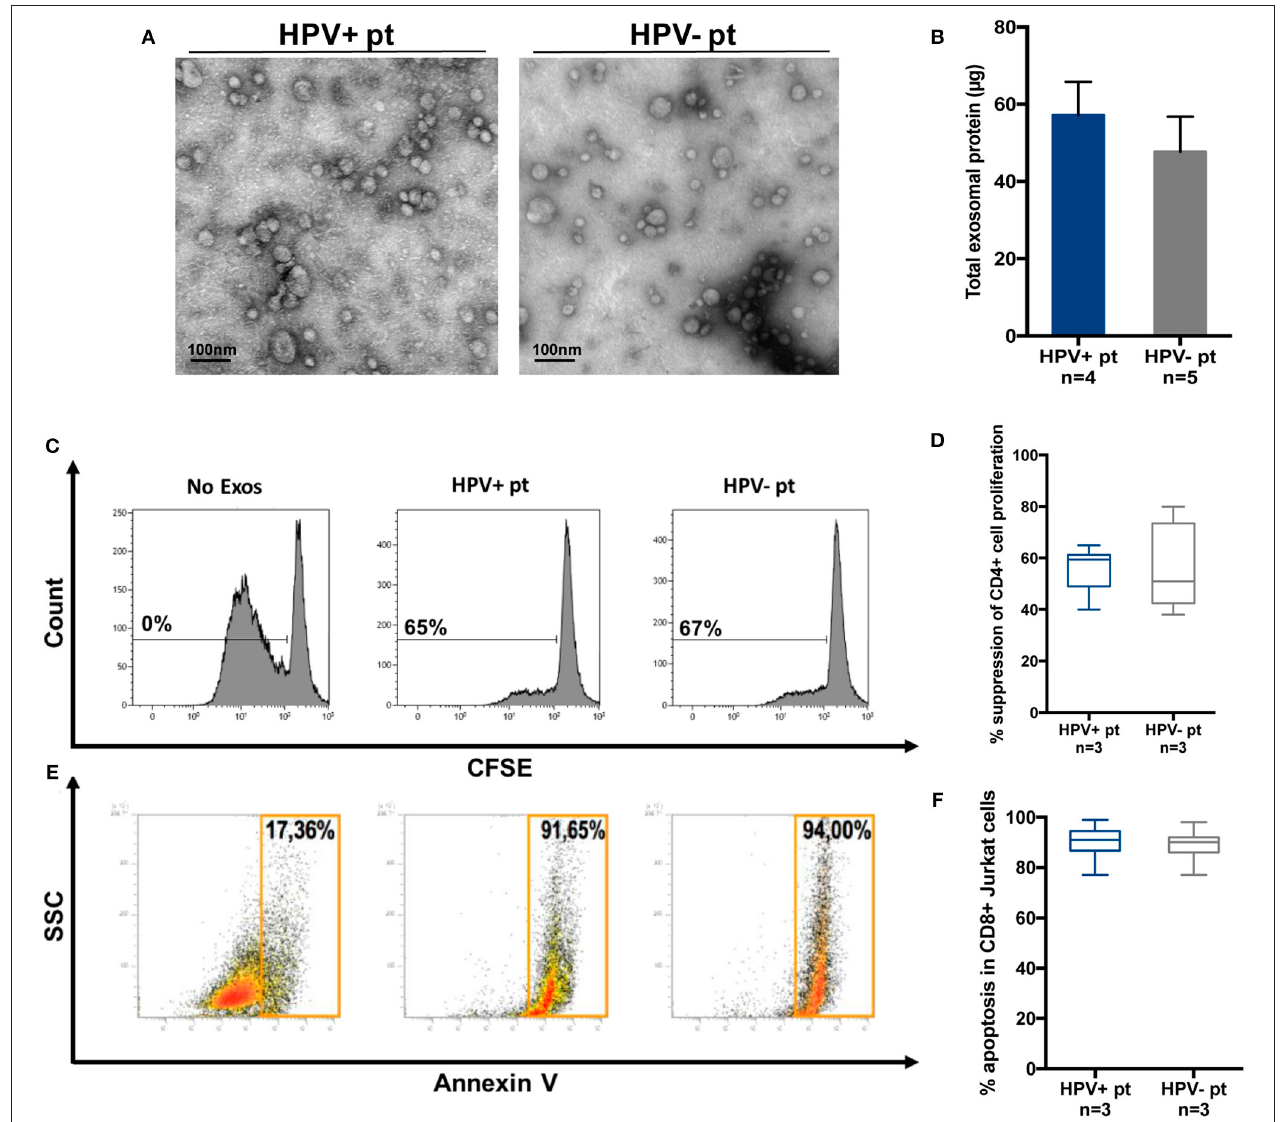
FIGURE 7 | Molecular and functional characteristics of exosomes isolated from plasma of HPV( + ) or HPV( − ) patients. (A) Representative TEM images of plasma exosomes from HPV( + ) and HPV( − ) patients showing a diameter range of 30–100nm. (B) Protein levels in exosomes of HPV( + ) and HPV( − ) patients. (C,D) Representative flow data and cumulative data for CFSE-based proliferation assays with CD4 + T cells co-incubated with plasma exosomes of HPV( + ) or HPV( − ) patients. (E,F) Apoptosis induction in CD8 + Jurkat cells co-incubated with exosomes isolated from plasma of HPV( + ) or HPV( − )